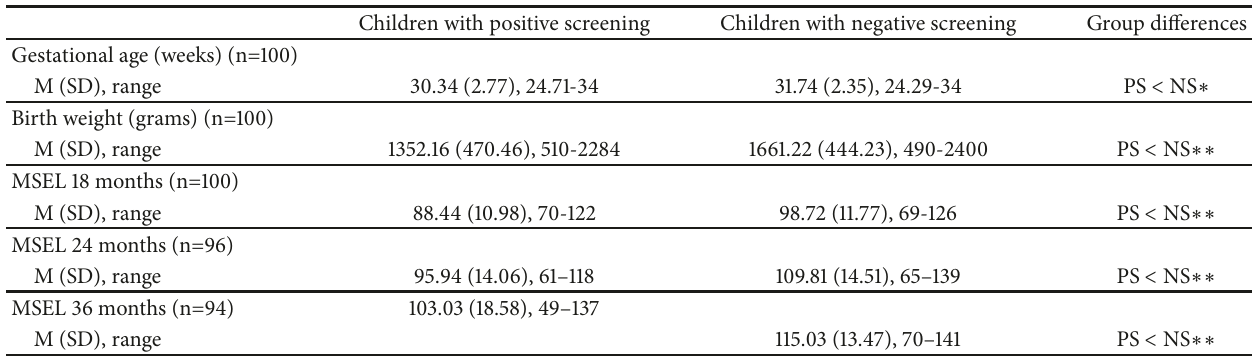
Table 4: Medical and developmentalcharacteristicsof pretermchildrenwith positive versusnegativescreeningfor autism spectrumdisorder. Children with positive screening Children with negative screening Group